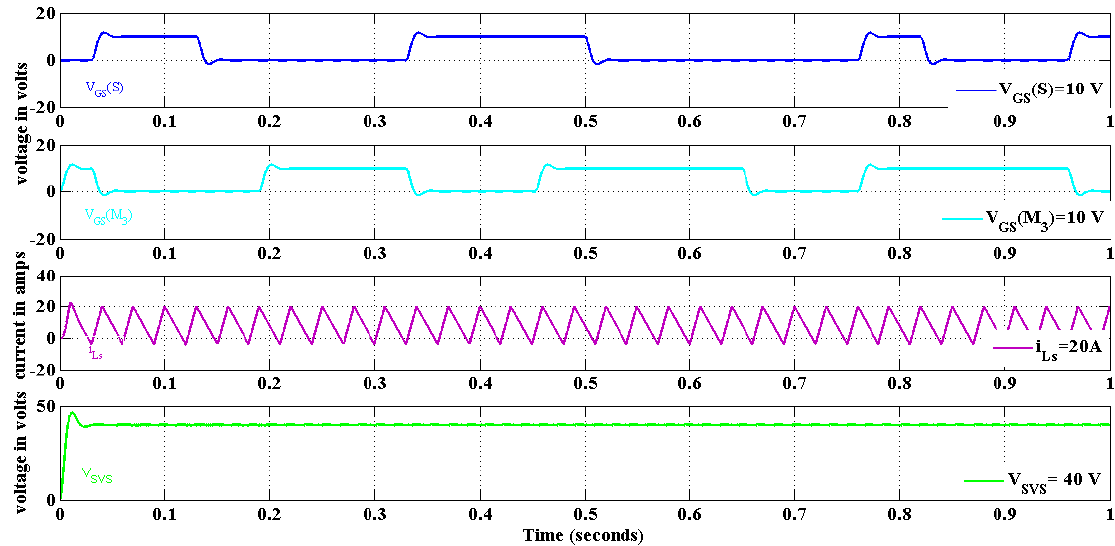
Figure 16. Gate signals, output voltage and inductor currents for buck mode.